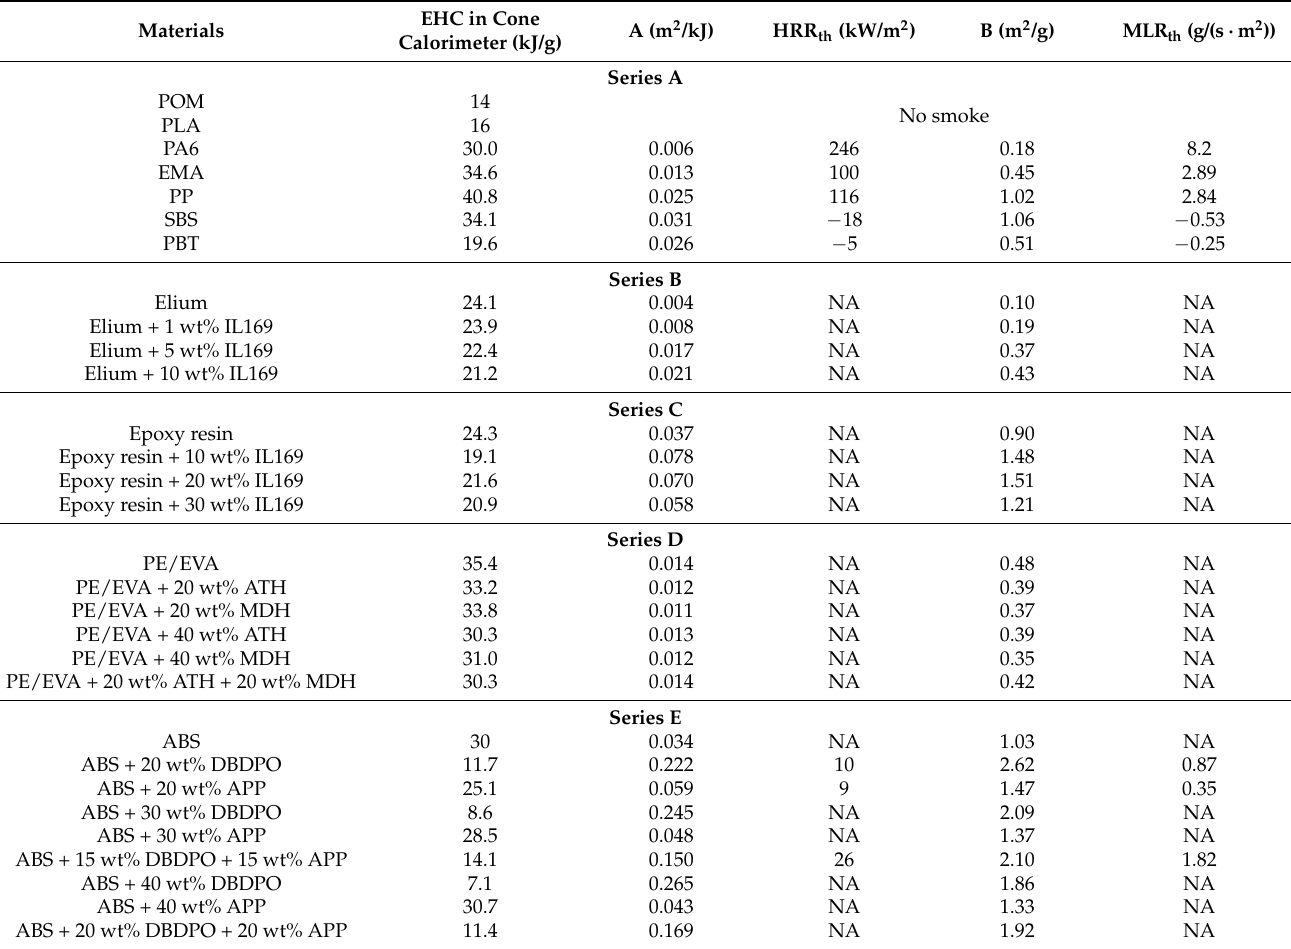
Table 1. Main intrinsic smoke